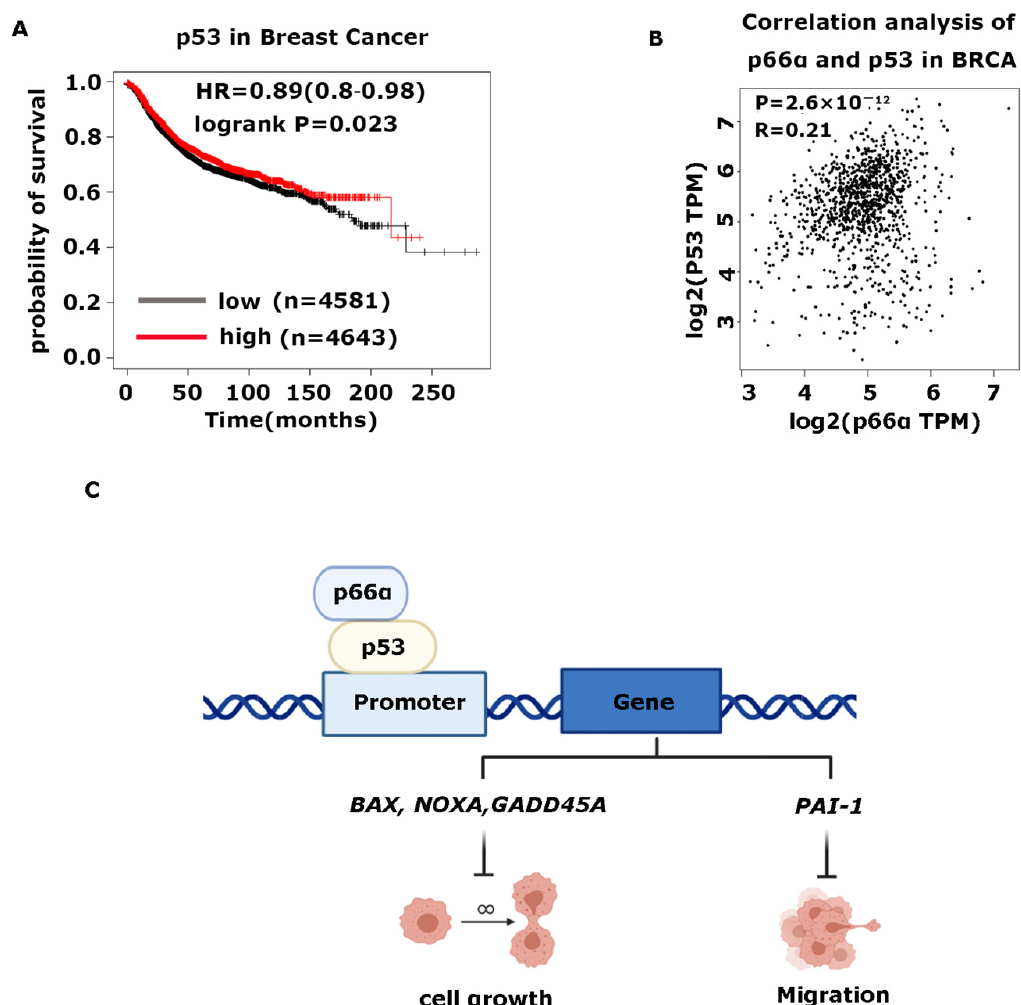
Figure 6. High expression of p66 α and p53 is positively correlated with and predicts a good prognosis in breast cancer. ( A ) Kaplan-Meier plot of the relapse-free survival of patients with breast cancer in whole data sets stratified by p53 expression. ( B ) Scatter plot showed that p66 α and p53 were positively correlated in breast cancer. The p value was calculated via Pearson’s ranking correlation coefficient analysis. BRCA: breast invasive carcinoma (TCGA database). TPM: Transcripts Per Kilobase of exon per Million mapped reads. ( C ) Schematic model for p66 α mediated p53 transactivating genes expression. p66 α interacted with p53 and promoted the transcriptional activation ability of p53 by enhancing p53 binding in target promoters, including genes that control cell growth, such as BAX, GADD45A, and NOXA , and that control cell migration such as PAI-1.